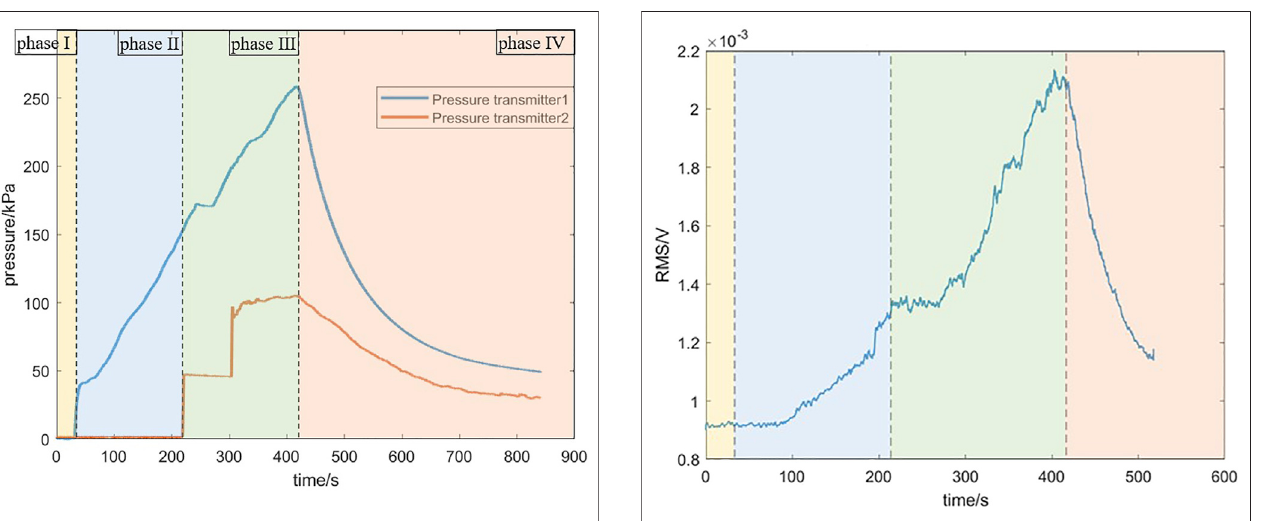
FIGURE 3 | Pressure variation in the oil-based magnetic fl uid seal